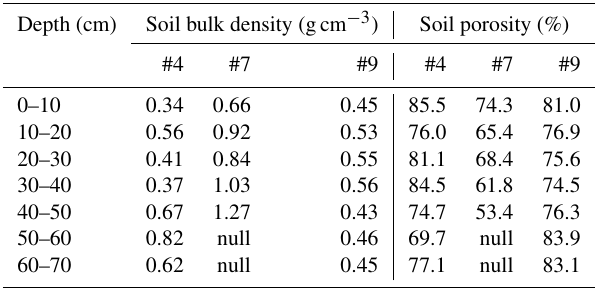
Table 4. Soil bulk density and soil porosity within the active layer at different depths from October 2015 to August 2016 at the Mahan Mountain. The location and information of the sampling sites are shown in Fig. 1b and Table 3, respectively.